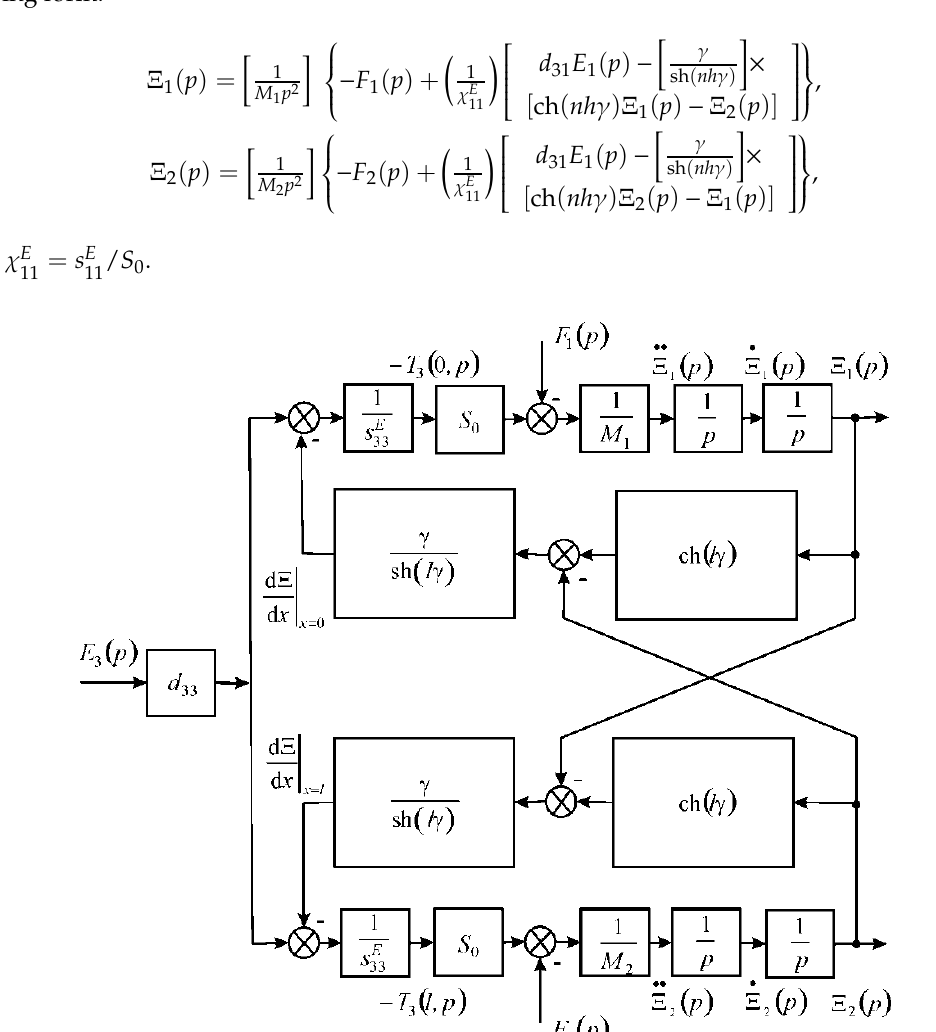
Figure 4. Parametric structural schematic diagram of the multilayer piezoactuator for longitudinal piezoeffect with voltage control.